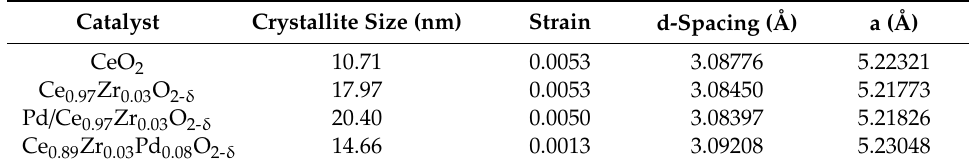
Table 3. d-spacing and strain calculations of the respective materials.